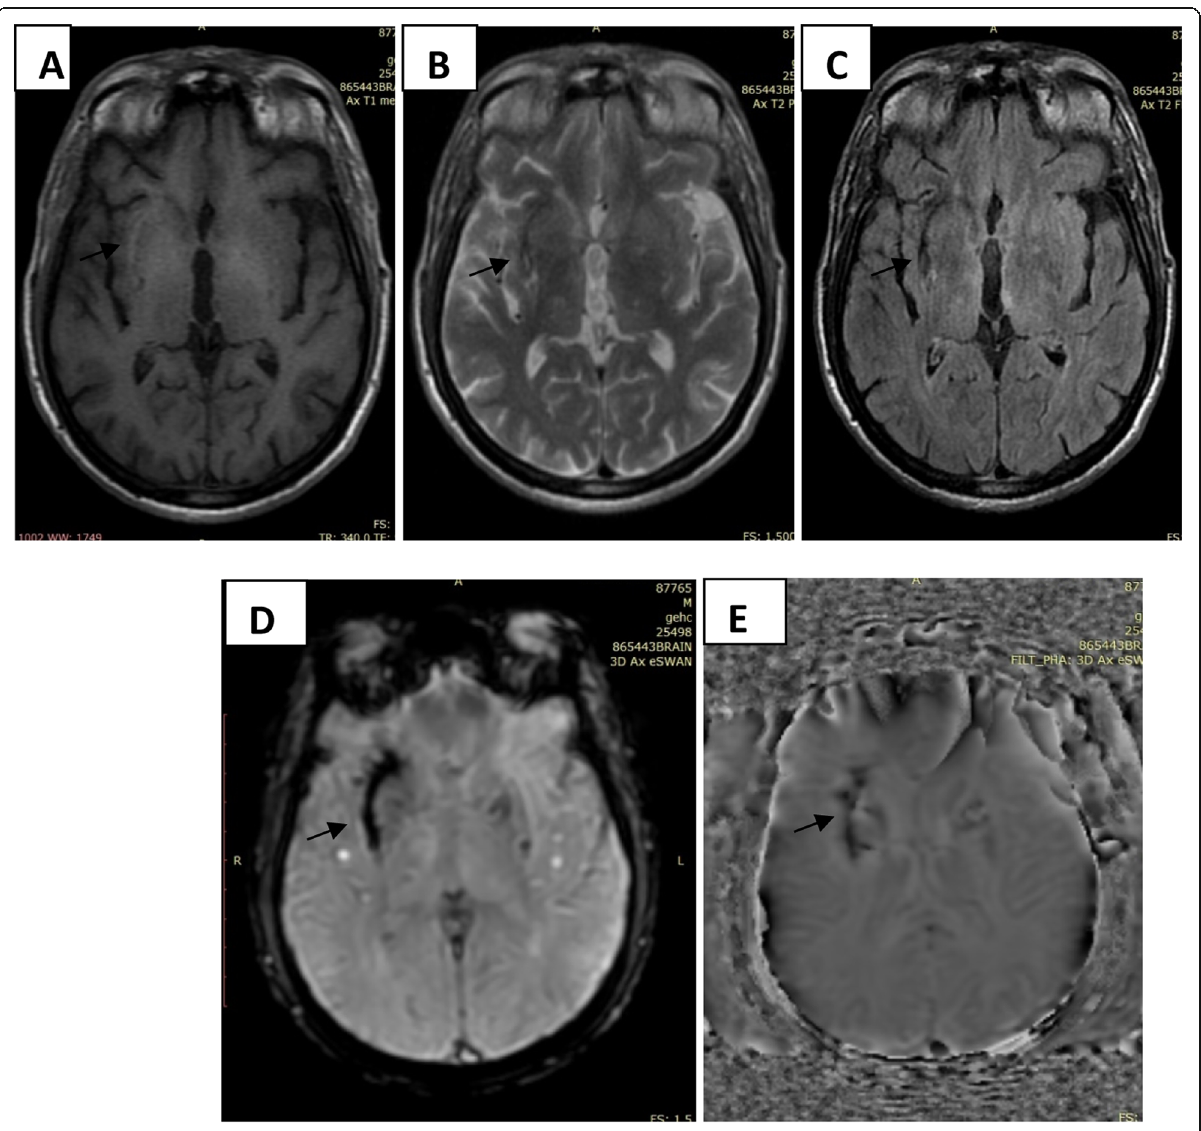
Fig. 5 Male patient aged 57years old, presented with seizures and medical history of hypertension. MRI brain was done and showed faint hyperintense curvillenear lesion seen in the right external capsule in T1WI ( a ) and displayed hypointense signal in T2WI and FLAIR sequences ( b , c ). SWI showed hypointense signal with blooming effect ( d ), and filter phase showed hypointense signal ( e ) denoting right external capsule hematoma